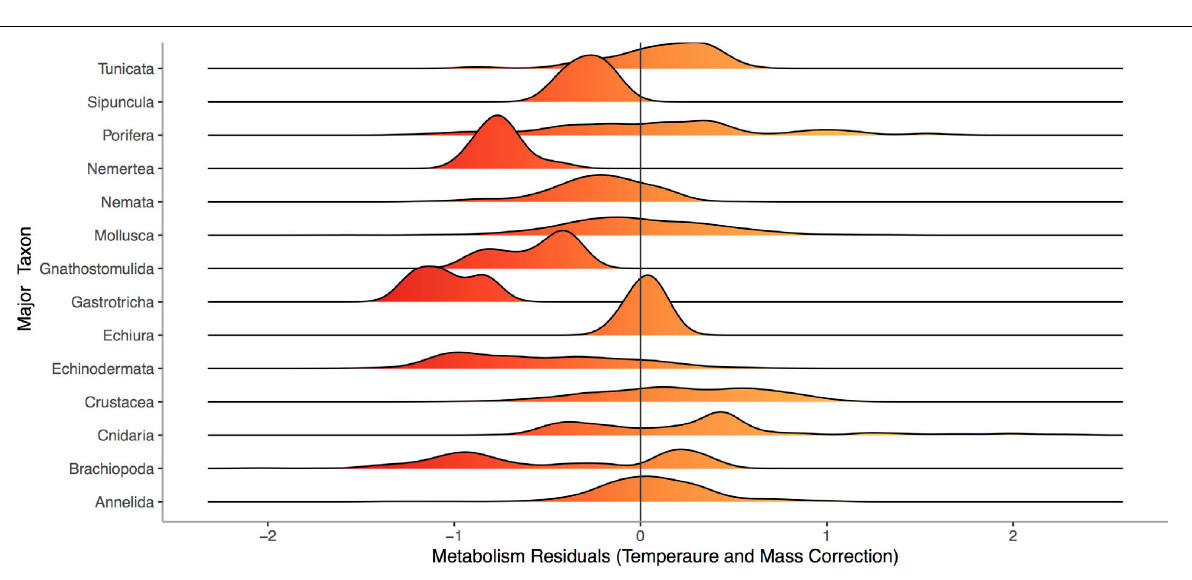
FIGURE 2 | Distribution of residuals for each of 14 phyla from a model fitting Log 10 Metabolic Rate (Joules per Day) as a function of Log 10 Mass (Joules) and 1/Temperature ( ◦ K), using data from the same 13,478 individuals from 444 species shown in Figure 1 . Colors denote large negative (red) to large positive (orange) residuals of the relationship between respiration and